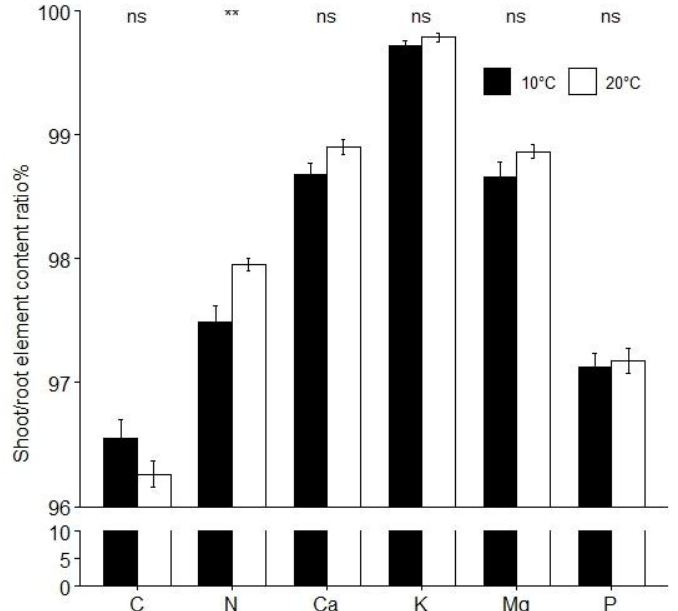
Figure 2. Shoot/root C, N, Ca, K, Mg, P content ratio of plants grown at two root temperature treatments (10 and 20 °C) in Exp-2. Mean and standard deviation were shown. Statistical analysis was performed by t -test. Levels of significance were represented by: ns not significant, ** 0.001 < p < 0.01.